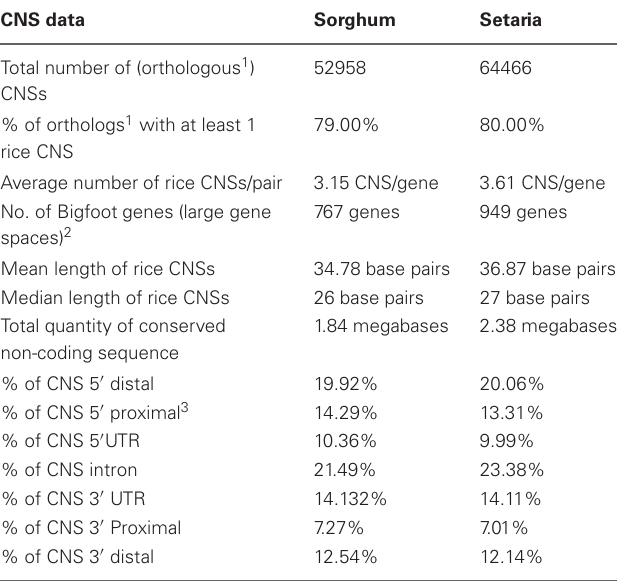
Table 2 | Summary of CNS distributions in Os-Sb and